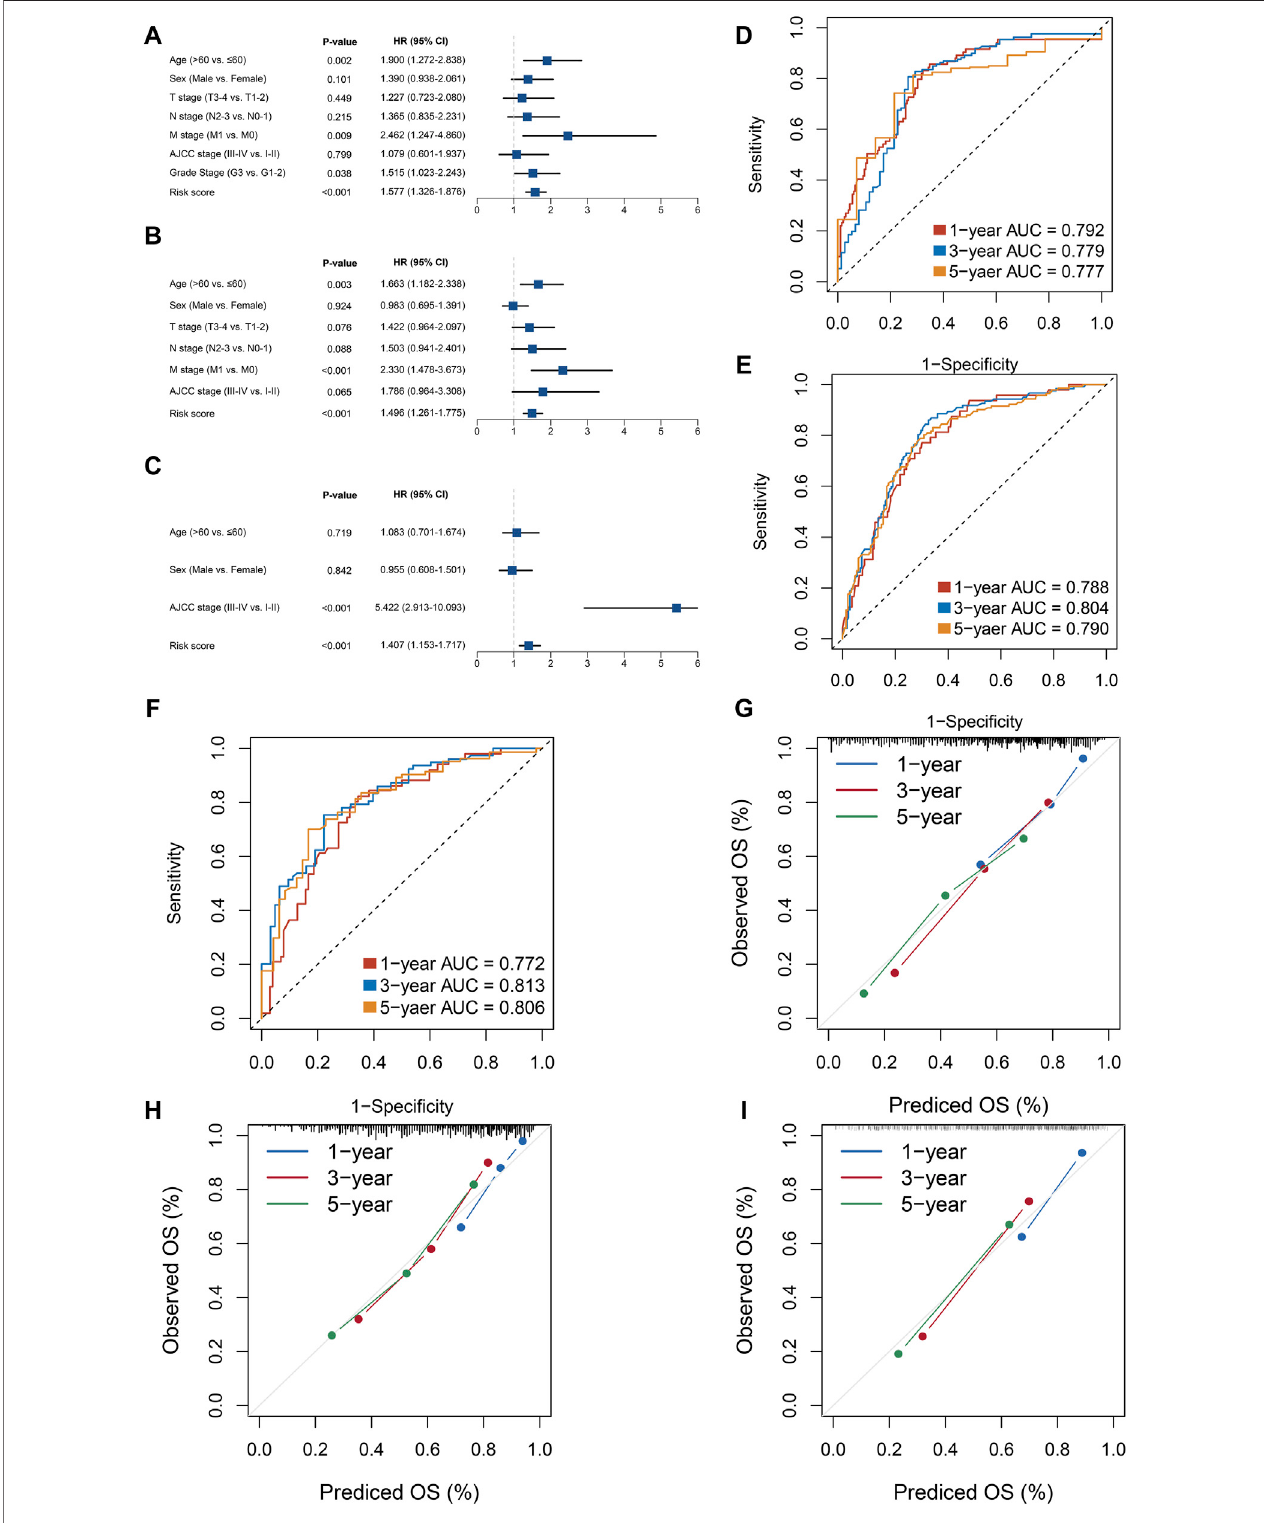
FIGURE 3 | Evaluation of the PPSM model effectiveness in three cohorts. (A – C) Multivariate COX regression analysis of the risk score in the three cohorts: TCGA (A) , GSE62254 (B) , and GSE15458 (C) . (D – F) ROC analysis for the three cohorts: TCGA (D) , GSE62254 (E) , and GSE15458 (F) . (G – I) Calibration plots were used to compare the actual probabilities and the predicted probabilities of OS in the three cohorts: TCGA (G) , GSE62254 (H) , and GSE15458 (I) .